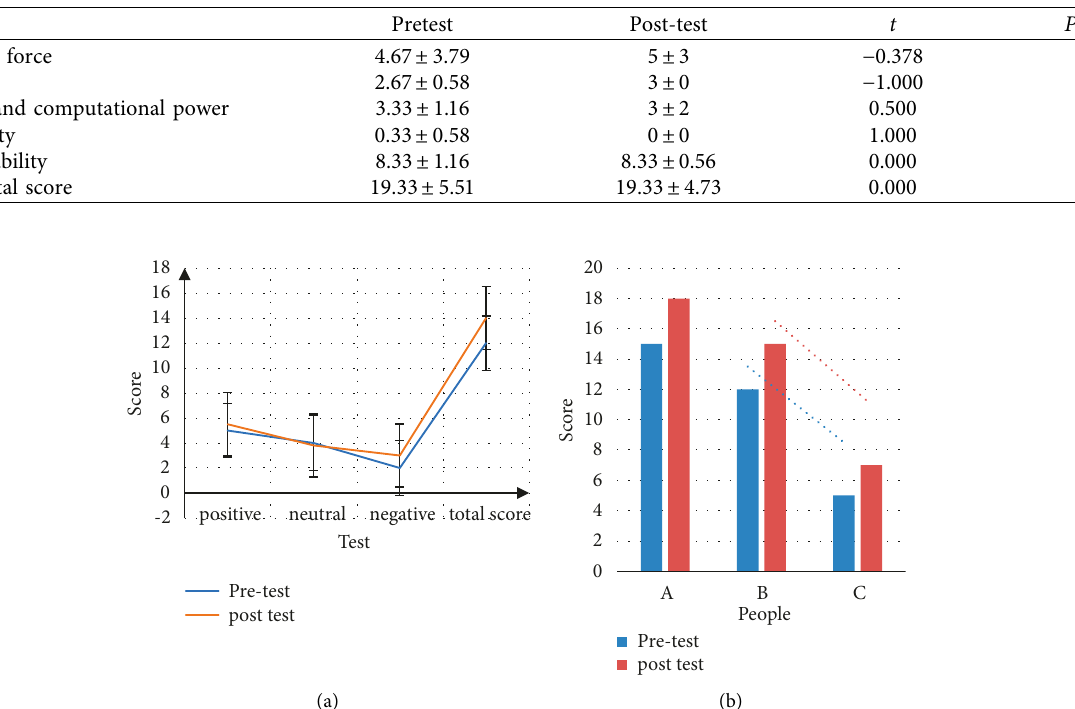
Figure 9: Autobiographical memory test and autobiographical memory total score. (a) Comparison of autobiographical memory test scores before and after the test. (b) Total autobiographical memory scores of 3